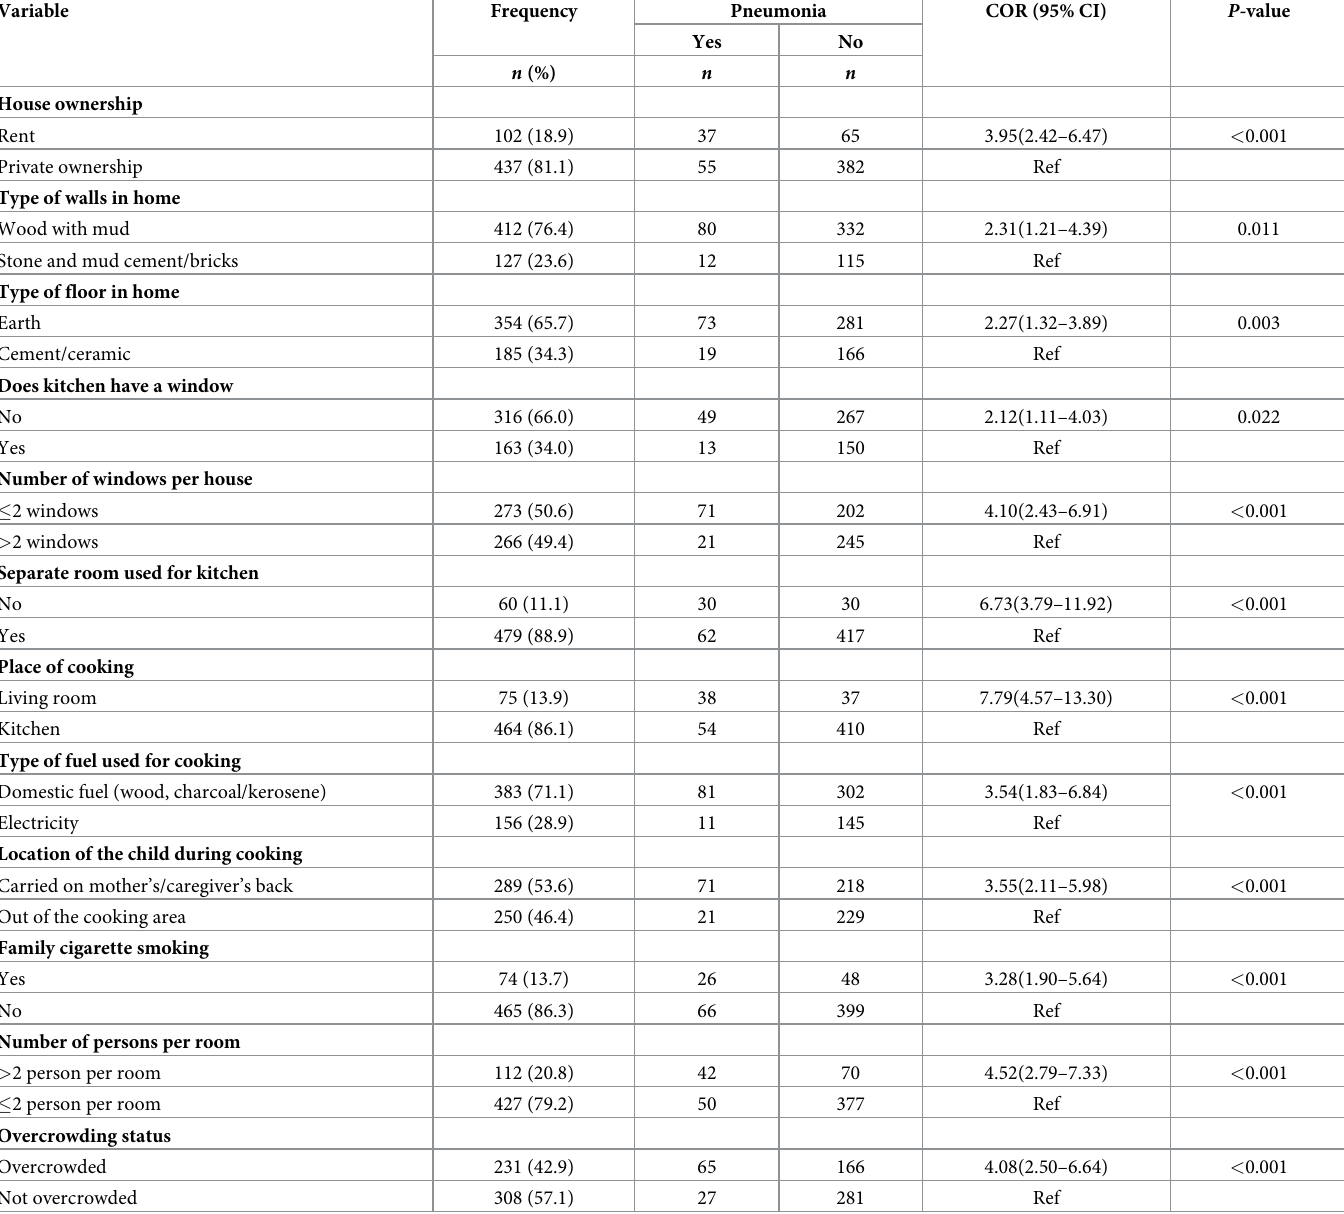
Table 2. Bivariate analysis of the associations of housing and environmental factors with pneumonia among children under five in peri-urban areas of Dessie City, north-eastern Ethiopia, January—March